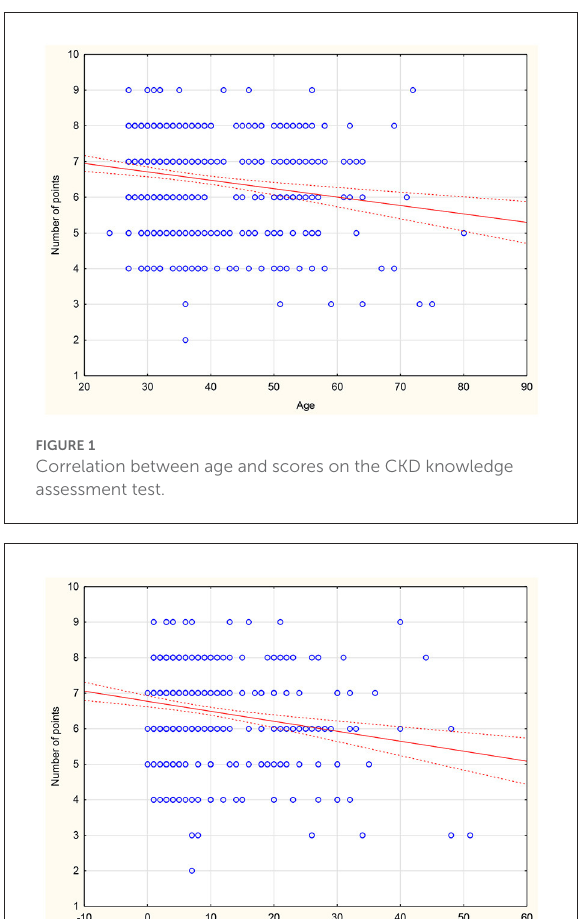
countries, results obtained from surveys assessing physicians’